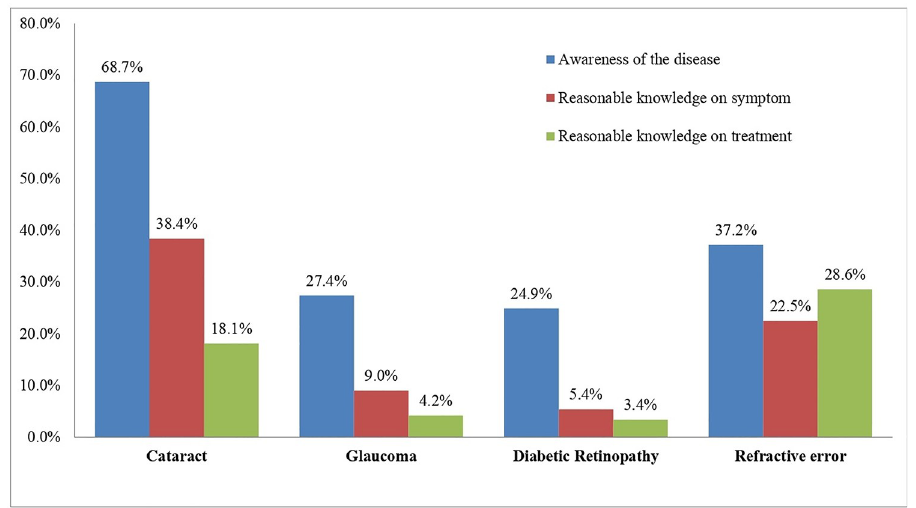
Fig 3. The baseline EHL scores of the study participants.